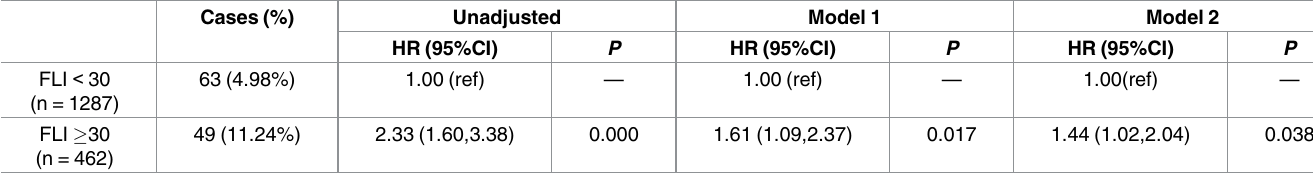
Table 7. Sensitivity analysis on the association between FLI with IVBS in cross-sectional analysis. Cases